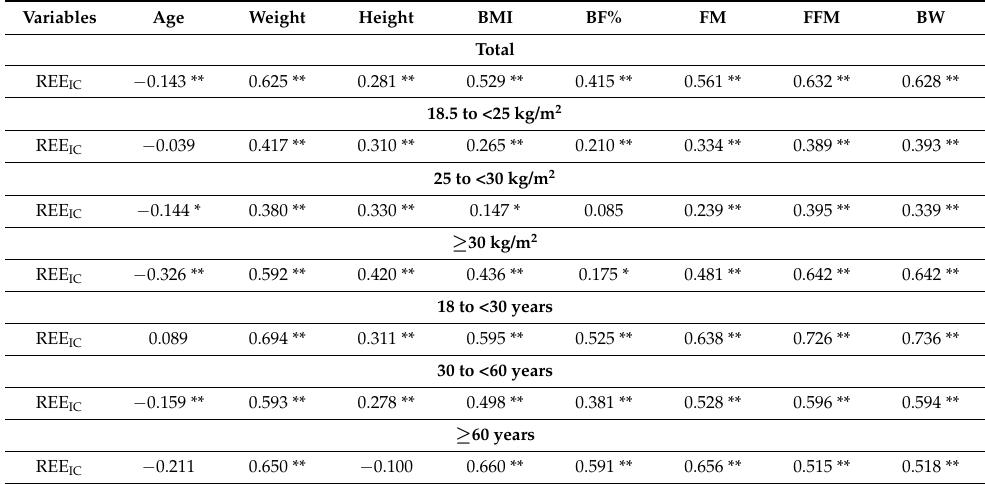
Table 5. Linear correlations between REE IC (Kcal/d) and independent